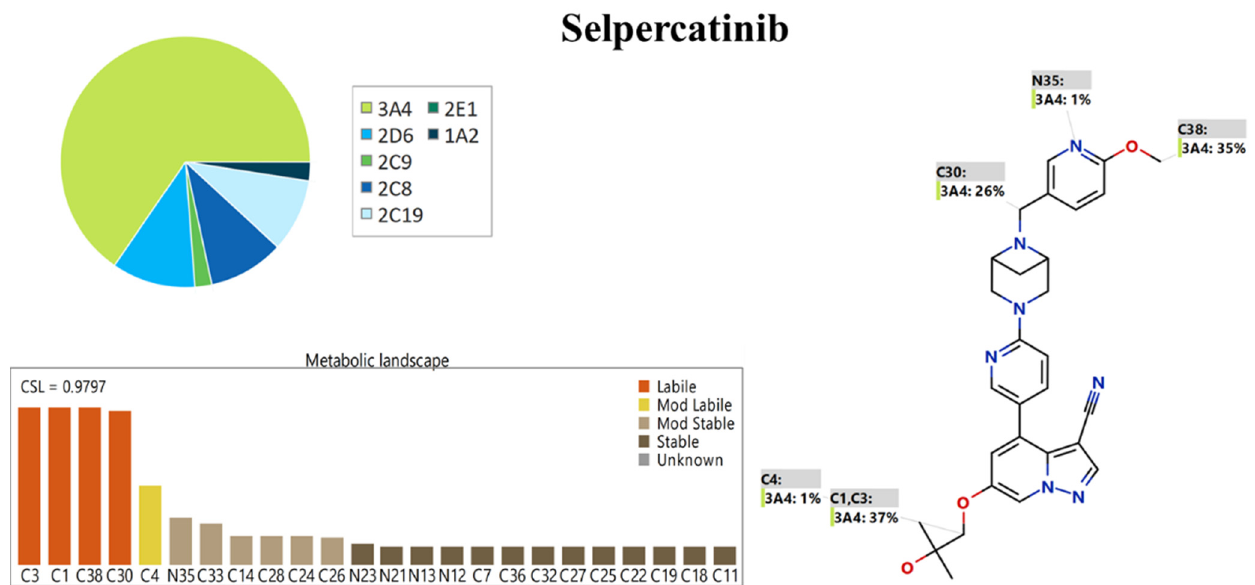
Figure 2. Metabolic landscape of SLP showing CSL (0.9797) and the proposed high SLP metabolic rate.